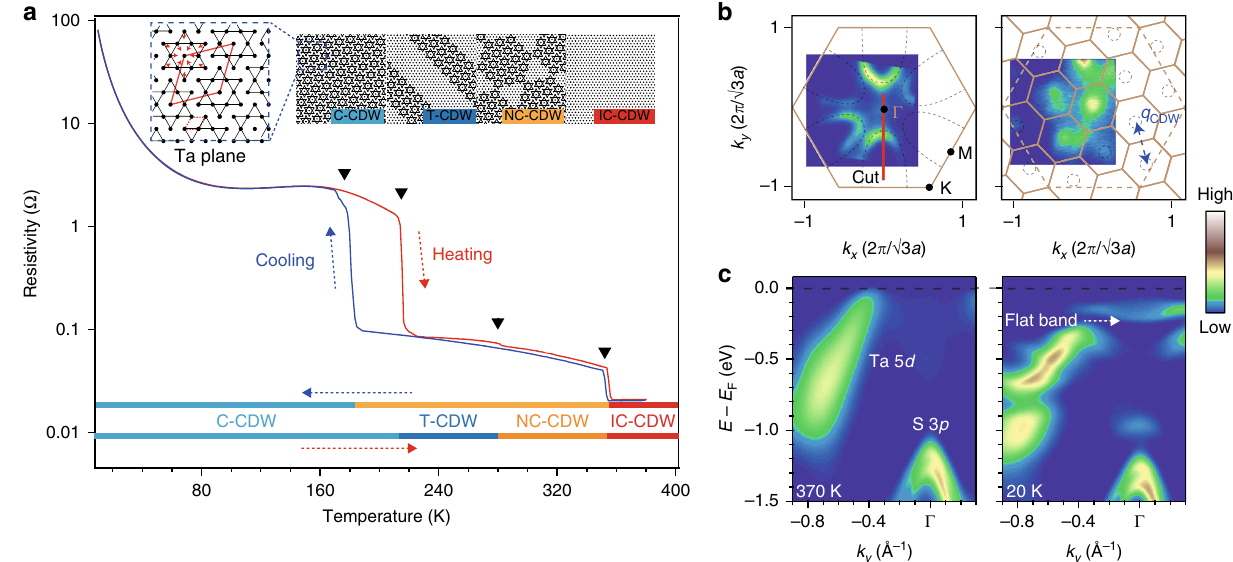
Fig. 1 Transport property and electronic structure of 1 T -TaS 2 . a Temperature dependence of in-plane resistivity taken upon heating and cooling. The black arrows mark the fi rst-order transition points. The bars below the curves indicate temperature intervals corresponding to the different phases. Inset panels in a are schematic illustrations for the in-plane lattice modulations in the commensurate CDW (C-CDW) phase, nearly commensurate CDW (NC- CDW) phase, Triclinic CDW (T-CDW) phase, and In-commensurate CDW (IC-CDW) phase, respectively. The SD clusters are marked with the dark outlines. Black dots stand for the Ta atoms. b and c Fermi surface mappings and corresponding high symmetry cuts taken at 370 and 20 K, respectively. The cut momenta are illustrated as a red line in b